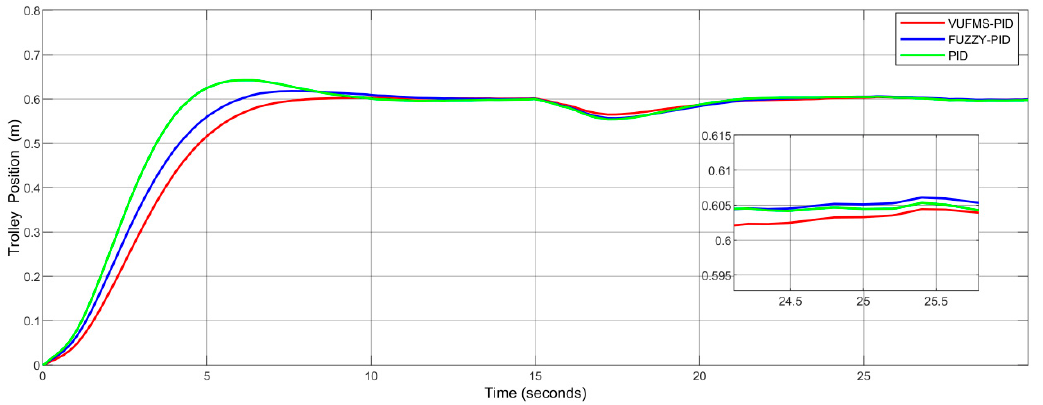
Figure 15. Trolley’s position using VUFMS-PID, FUZZY-PID and PID controller under working condition 1 with a crosswind and white noise.